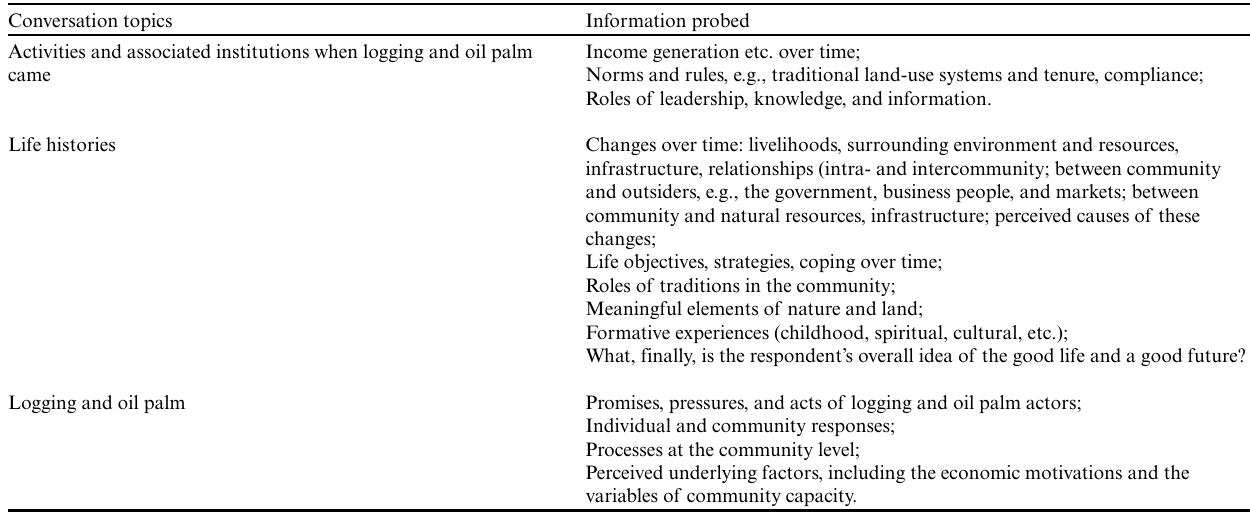
Table 1 . List of conversation